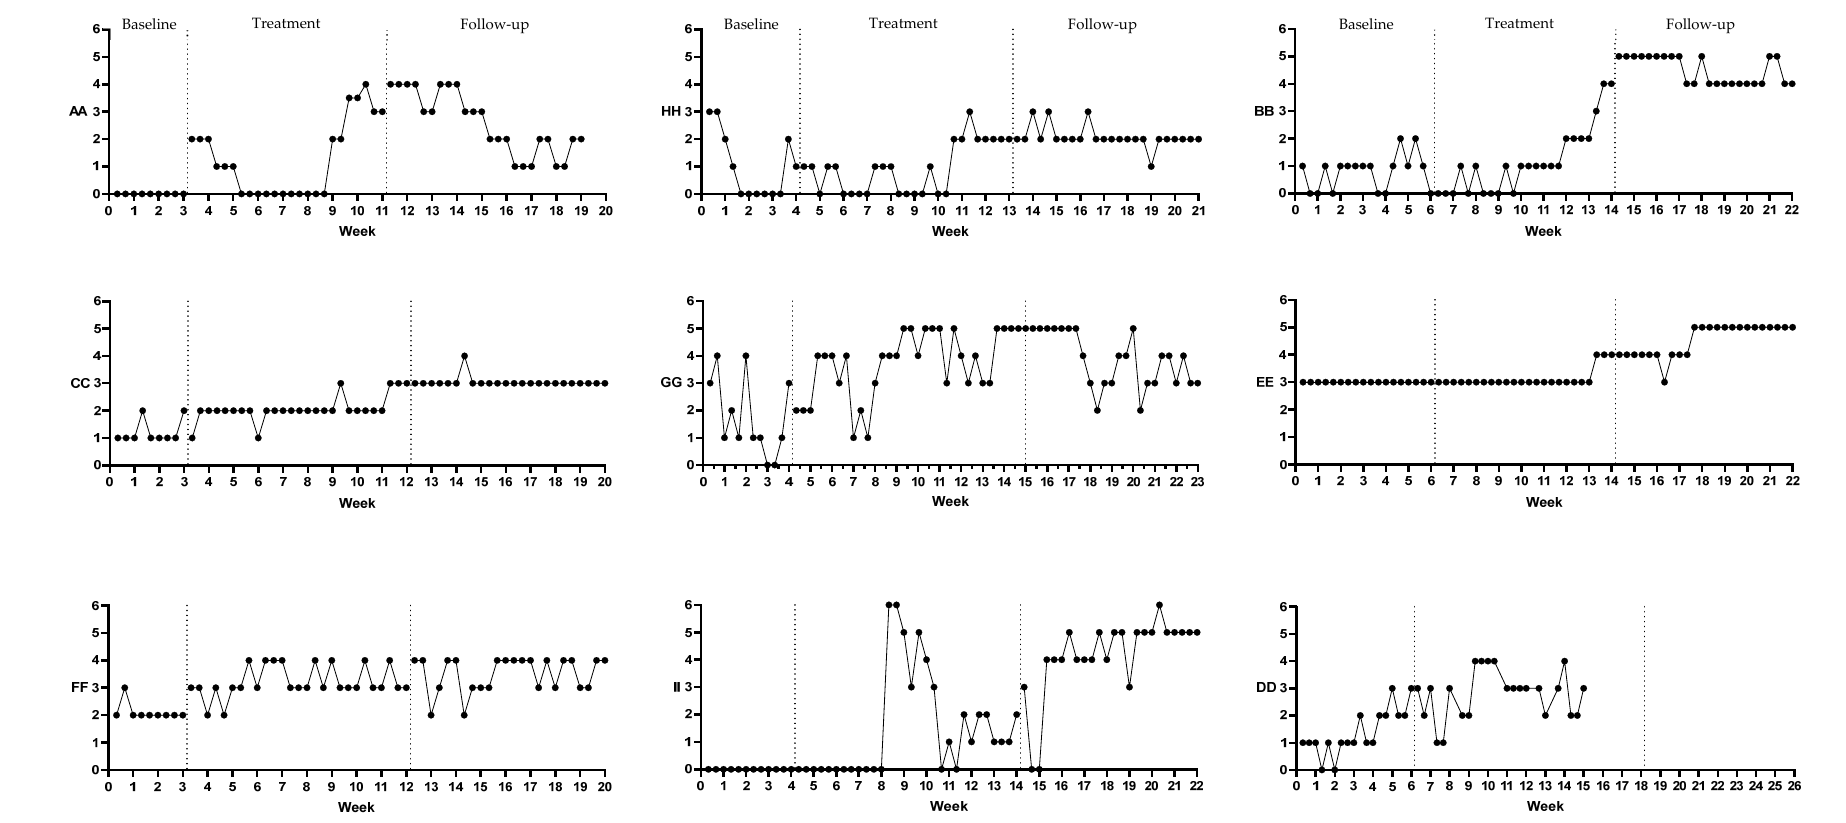
Figure 2. Participants’ self-reported subjective sexuality satisfaction across baseline, intervention, and follow up phases.